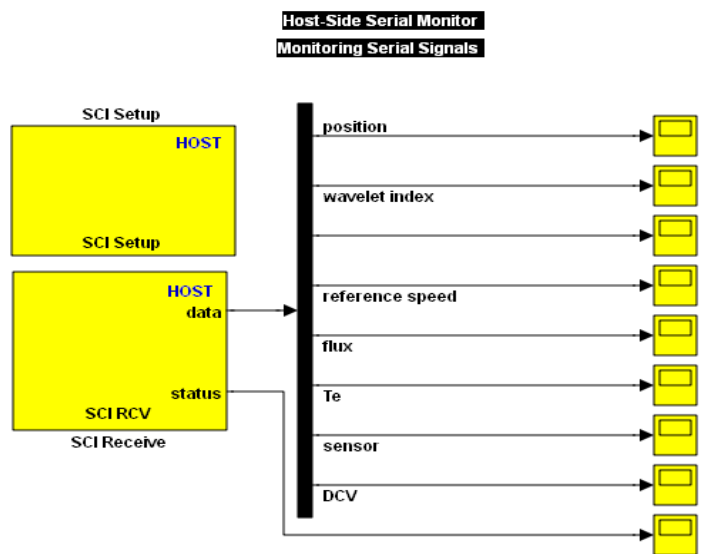
Figure 17. Serial communication Interface to show the experimental